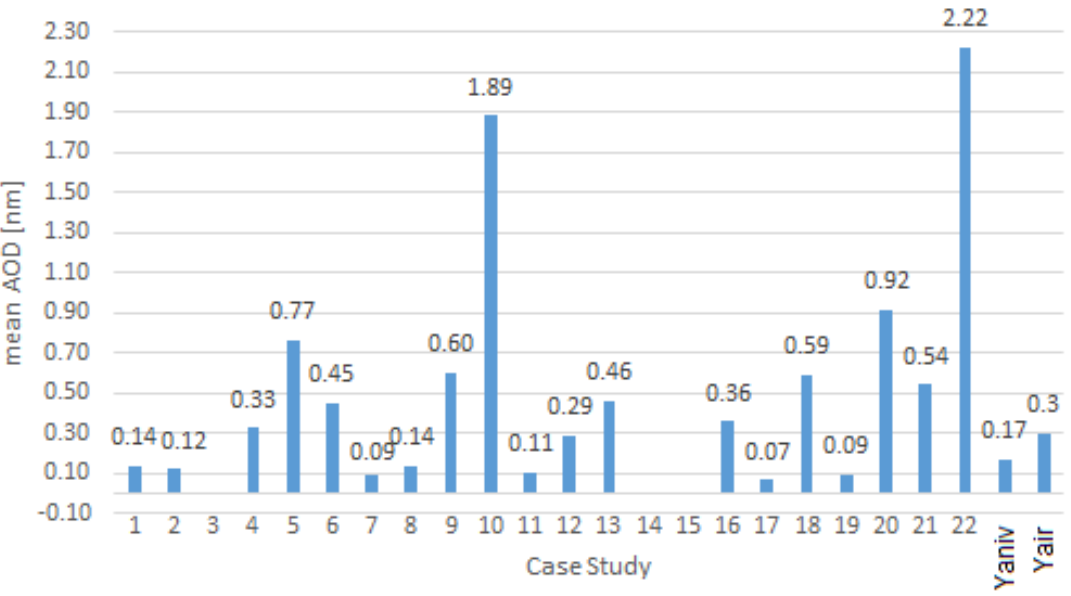
Figure 4. Mean Aerosol Optical Depth values [nm] for 19 out of 22 days and the 0.17 – 0.3 range of AOD mean fair weather values from previous studies [10,20].